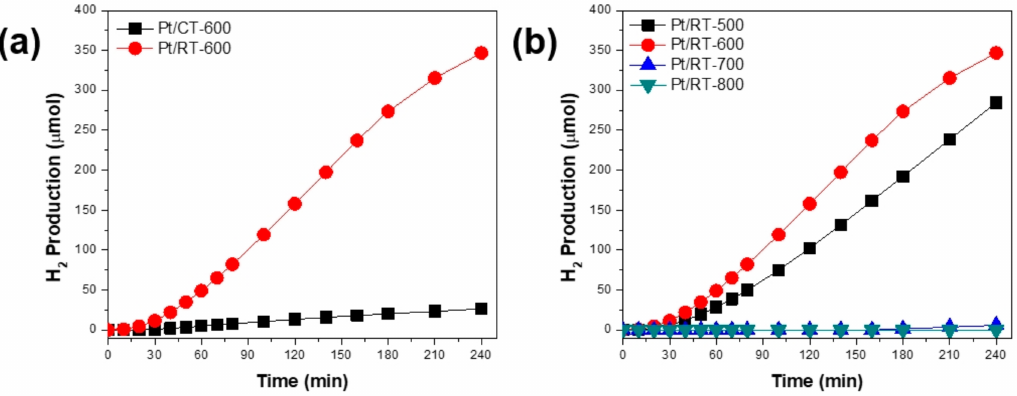
Figure 6. Hydrogen production amount of 1 wt % Pt-deposited TiO 2 photocatalyst: ( a ) CT-600 and RT-600; and ( b ) RT-500, RT-600, RT-700, and